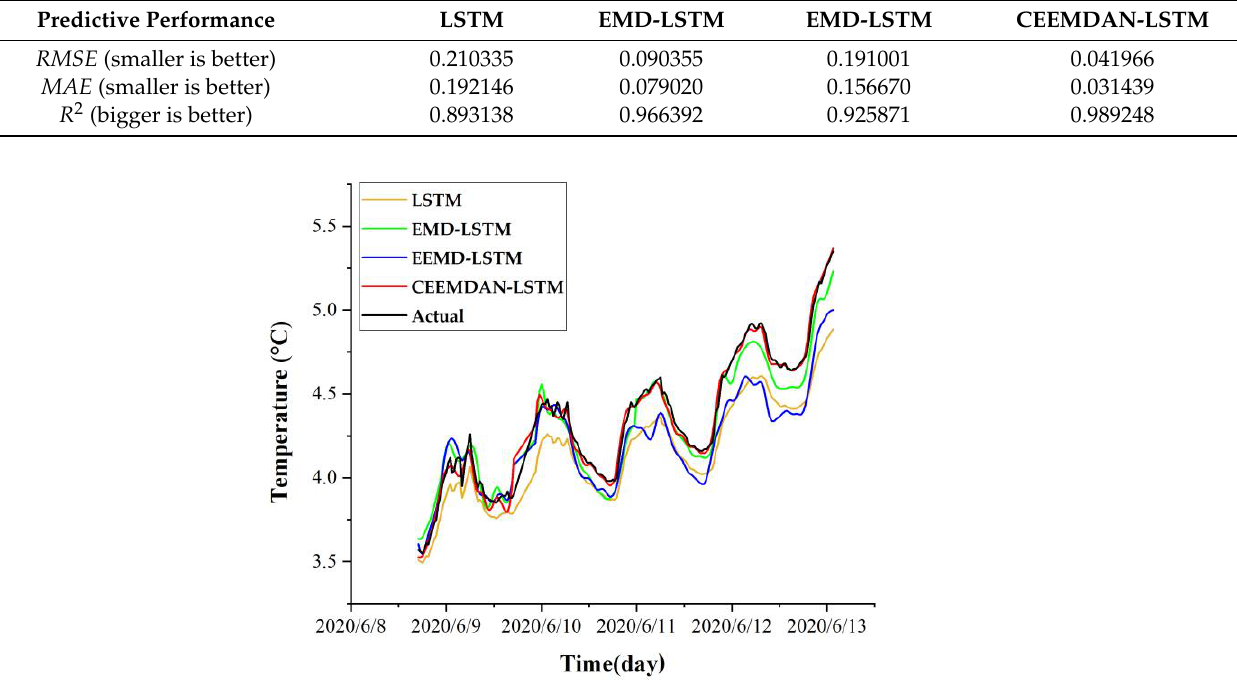
Figure 9. Comparison of prediction results of different models for 0.5 m under the right shoulder of the subgrade.